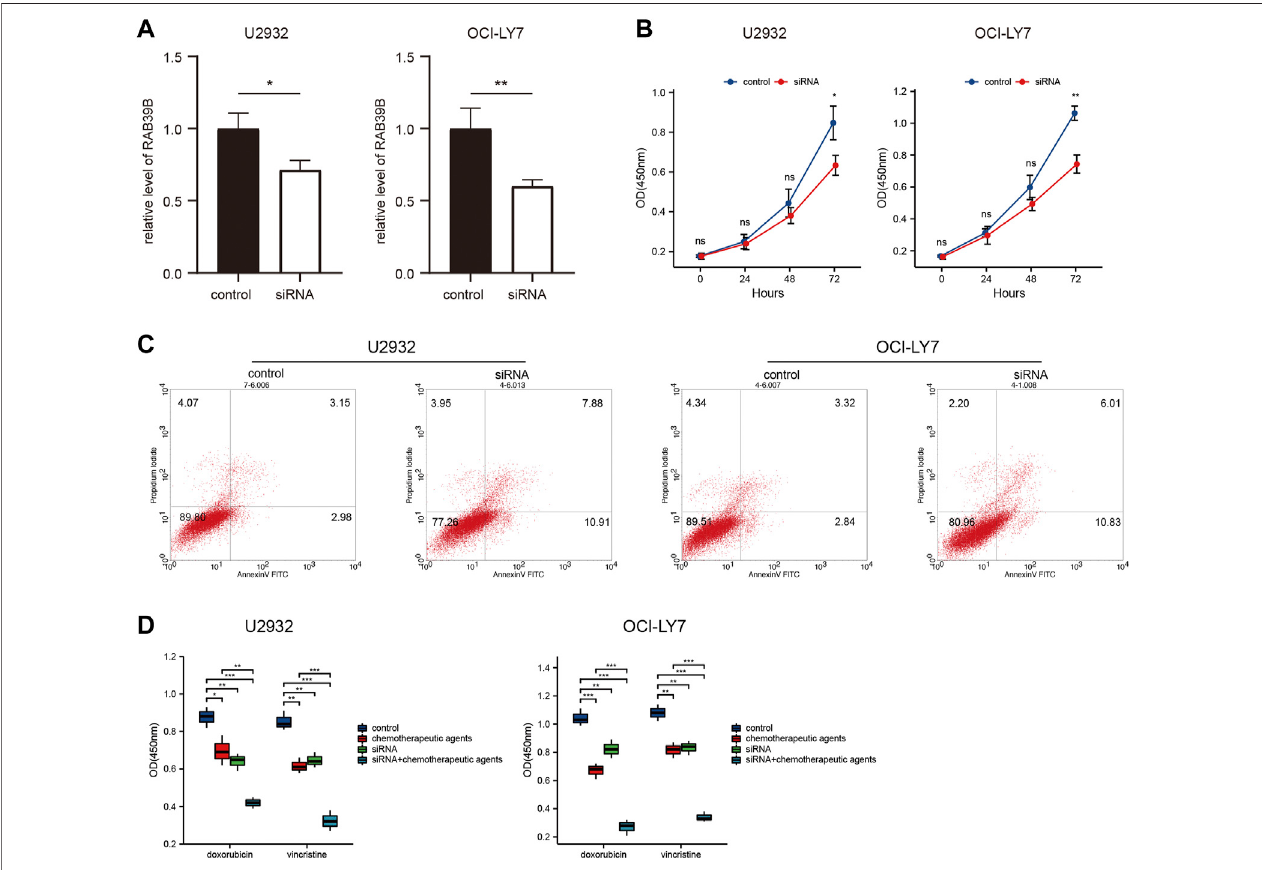
FIGURE8| RAB39BwasassociatedwithDLBCL cellproliferation, apoptosis, and drug sensitivity invitro . (A) RAB39BsiRNA transfection ef fi ciency inU2932 and OCI-LY7wasmeasuredbyqPCR. (B) CCK-8proliferationassayshowedthatRAB39BinhibitionresultedindecreasedproliferationofU2932andOCI-LY7DLBCLcells. (C) Inhibition of RAB39B resulted in increased apoptosis in U2932 (18.79%) and OCI-LY7 (16.84%) DLBCL cells. (D) Inhibition of RAB39B signi fi cantly increased the sensitivity of DLBCL cells to doxorubicin and vincristine.